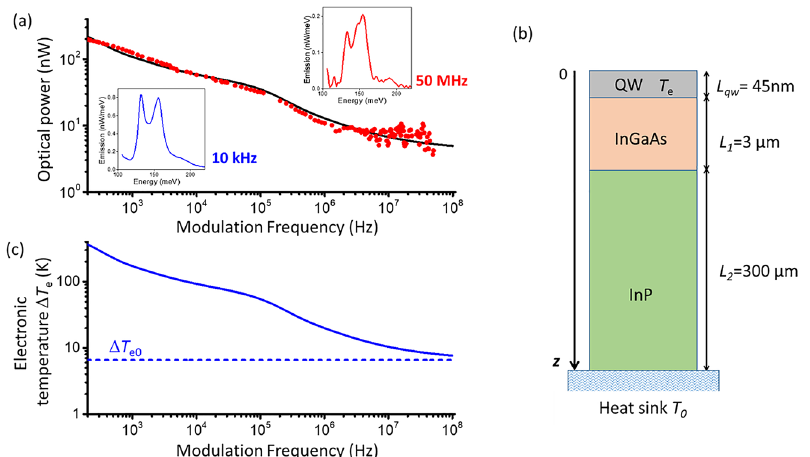
direct current (dc) power supplier. The emitted power is collected into a Fourier transform infrared spectrometer and then measured using a fast Mercury Cadmium Telluride (MCT) detector with a frequency cutoff at 50 MHz. The spectra are measured in a step-scan mode using a high frequency lock-in ampli fi er. In the bottom part of Figure 3b, we indicate the temporal form of the input current used to modulate the temperature of the electron gas. Experimental results of the frequency modulated thermal emission are shown in Figure 4a (dotted curve). In the insets of the fi gure, we provide spectra of the thermal emission for two frequency regimes. The spectra remain essentially identical, which proves that the emission signal arises from the incandescence of the polariton modes. In order to model the frequency dependence of the emitted power shown in Figure 4a,we developed a modelthat provides the temporal evolution of the electronic temperature T e . The model is one dimensional and assumes that the lattice (Figure 4b). The electronic temperature is different from the lattice temperature T ( z ) , and the thermal fl ux density that describes the heat exchanged between the electrons and the lattice is assumed to be of a simple form β / L ( T − T ( z (cid:1) 0 )) . Here, L QW e QW is the quantum well thick- conductivity (W/m K) and is treated as a fi tting parameter (see further). Heat is generated only in the quantum well layer, through the dissipation of electrical power, and then propa- gates toward the heat sink at the bottom of the semiconductor substrate maintained at a temperature T = 300 K. In 0 Figure 4b, we indicate the different semiconductor layers be- tween the quantum well and the heat sink.